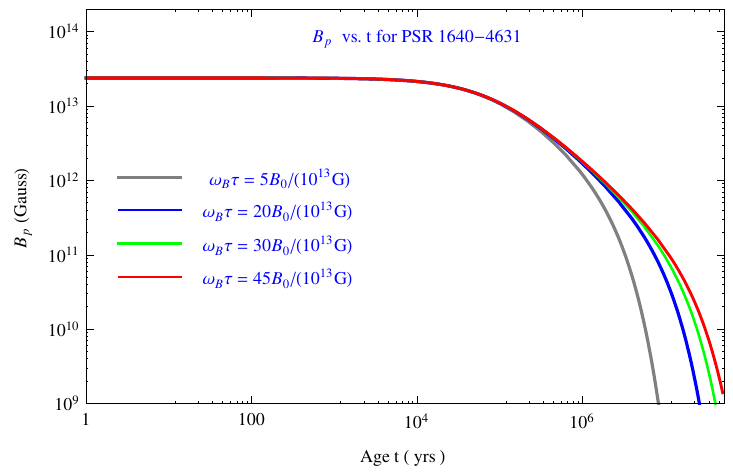
Figure 5. The dipolar magnetic field B p as a function of t for PSR J1640-4631 with n > 3.